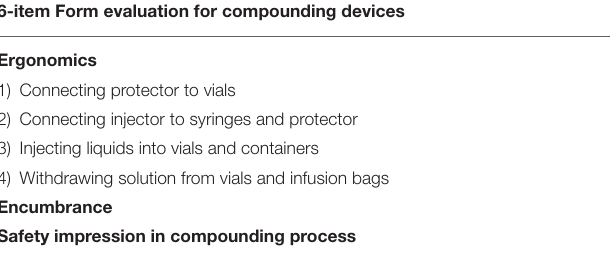
TABLE 1 | Evaluation items on ergonomics, encumbrance, and safety